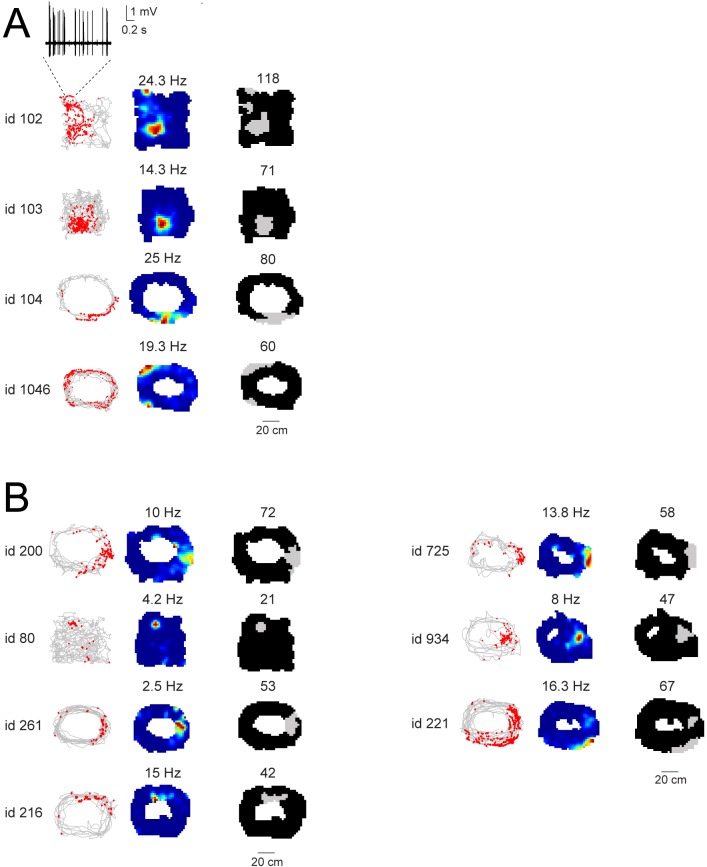
Spatial firing activity of identified and putative GCs.(A) Spike-trajectory plots (left) and rate maps (middle) for the identified GCs which were classified as spatially modulated (see Materials and methods for details). Cell id and maximal firing rates are indicated. In the right panels, firing fields are outlined as grey areas (see Materials and methods). The total size of the firing fields (expressed in number of pixels) is indicated. For cell id 102, the multiple firing fields might result from suboptimal spatial coverage, as indicated by the close-up magnification on a single-pass at the upper-left corner of the maze. The corresponding high-pass filtered juxtacellular spike trace is indicated. (B) Same as (A), but for ‘putative’ GCs.